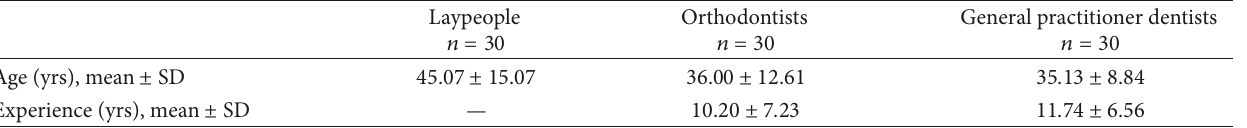
Table 1: Demographics of